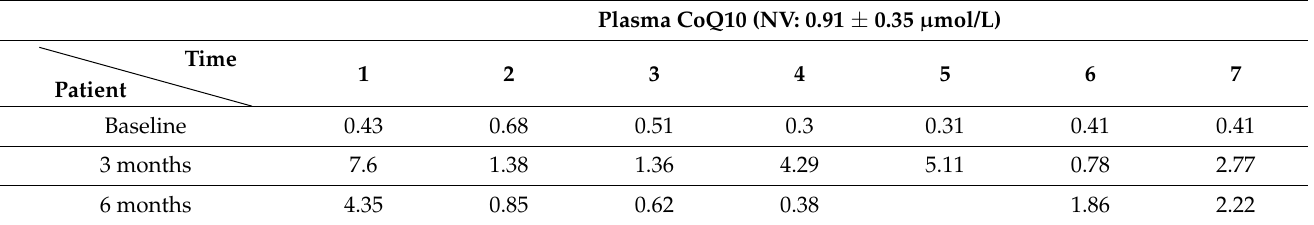
Table 2. A total of 6/7 patients presented low levels of plasma CoQ10 at the beginning of the study, which was corrected by treatment with